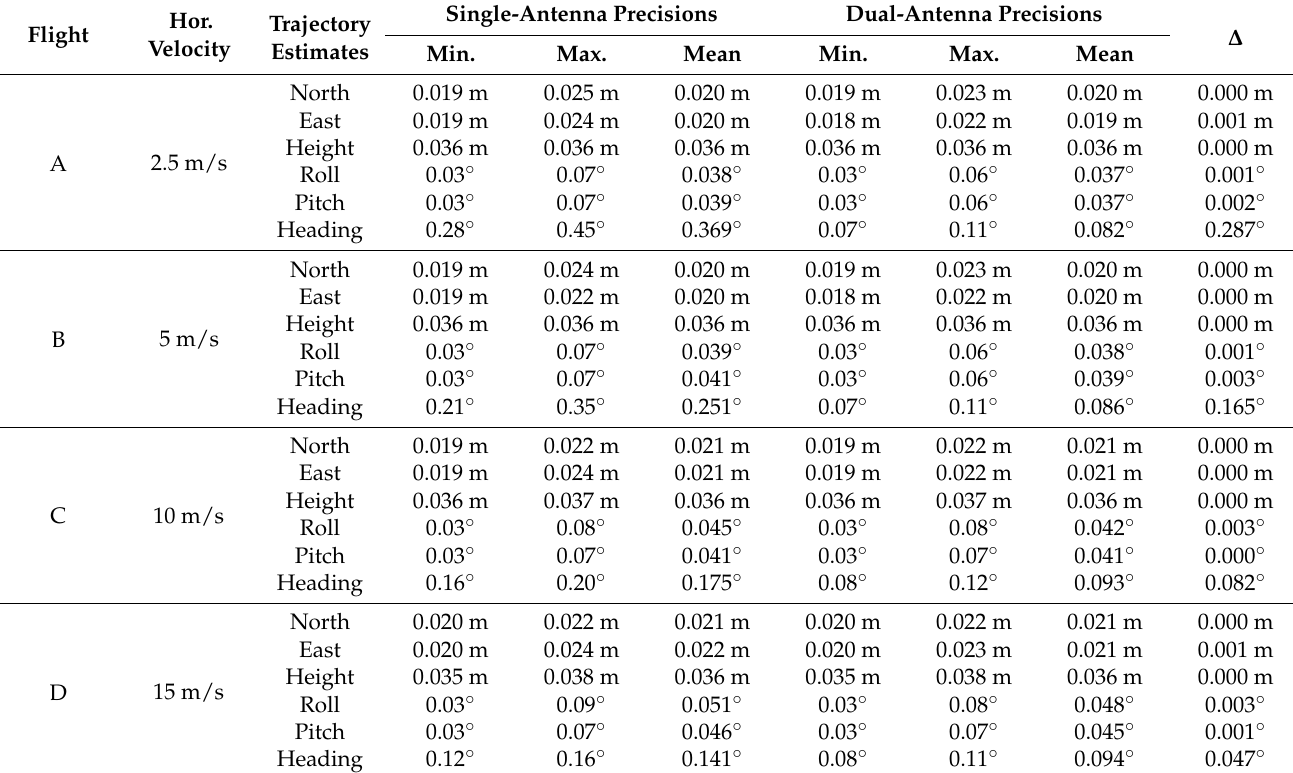
Table 5. Quantitative measures for single-antenna and dual-antenna GNSS/INS trajectory precisions. Flight